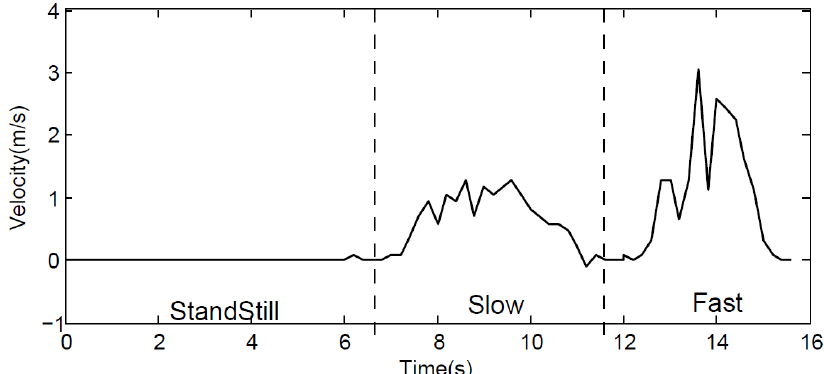
Figure 7. Pedestrian walking detection by utilizing the Doppler effect with 19.5 kHz